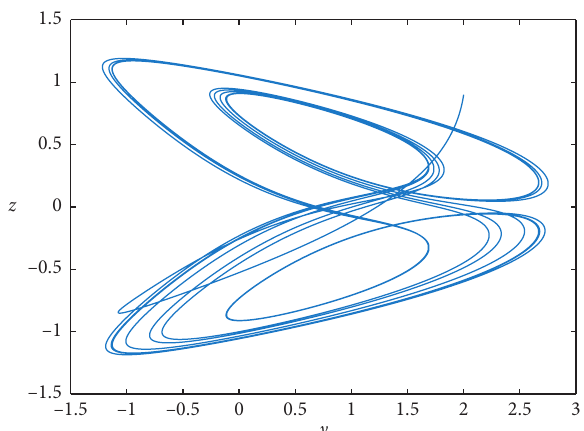
Figure 8: Dynamic behavior of fractional financial chaotic model with α � 0 . 95.